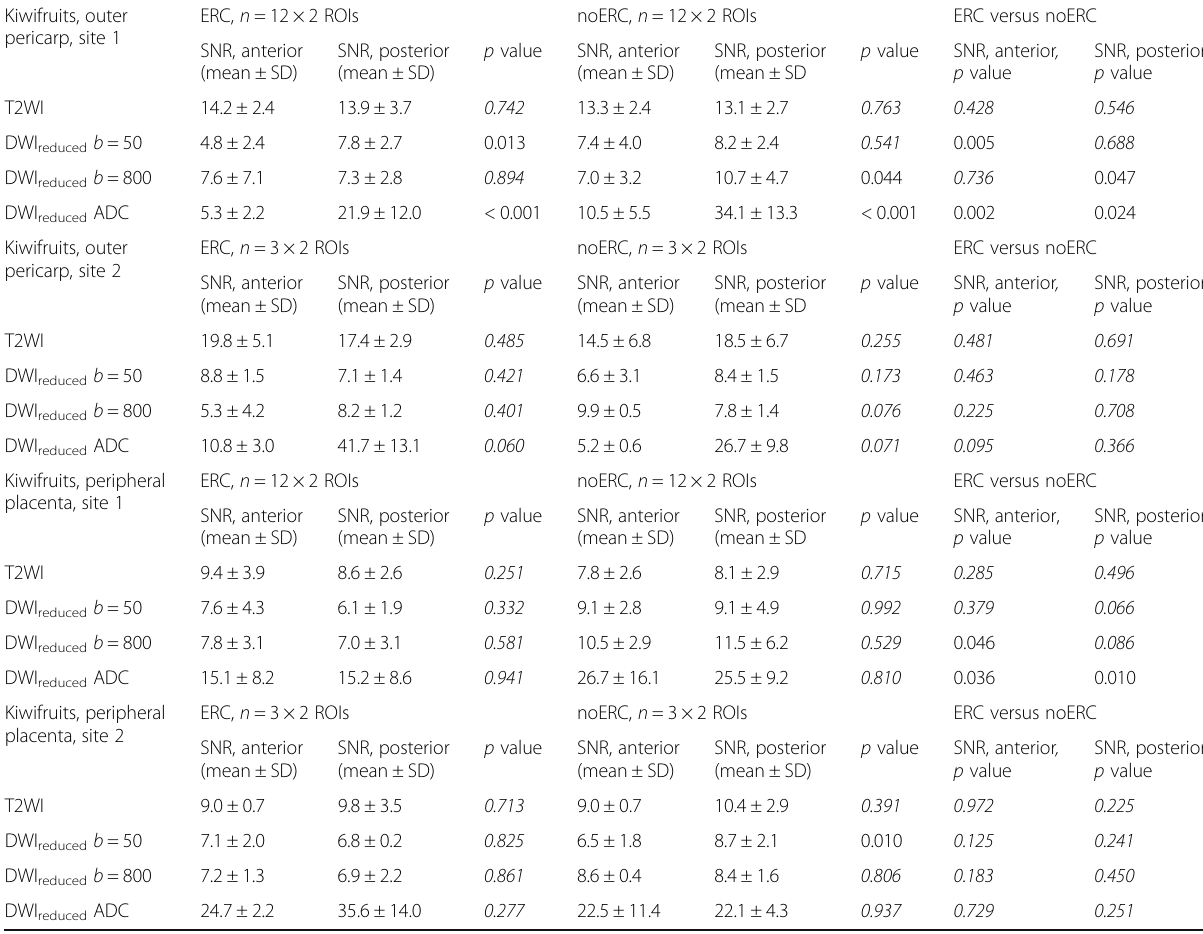
Table 2 Signal-to-noise ratios in kiwifruits examined with and without an endorectal coil at site 1 (twelve corresponding regions of interest in anterior and posterior locations) and at site 2 (three corresponding regions of interest in anterior and posterior locations) Kiwifruits, outer pericarp, site